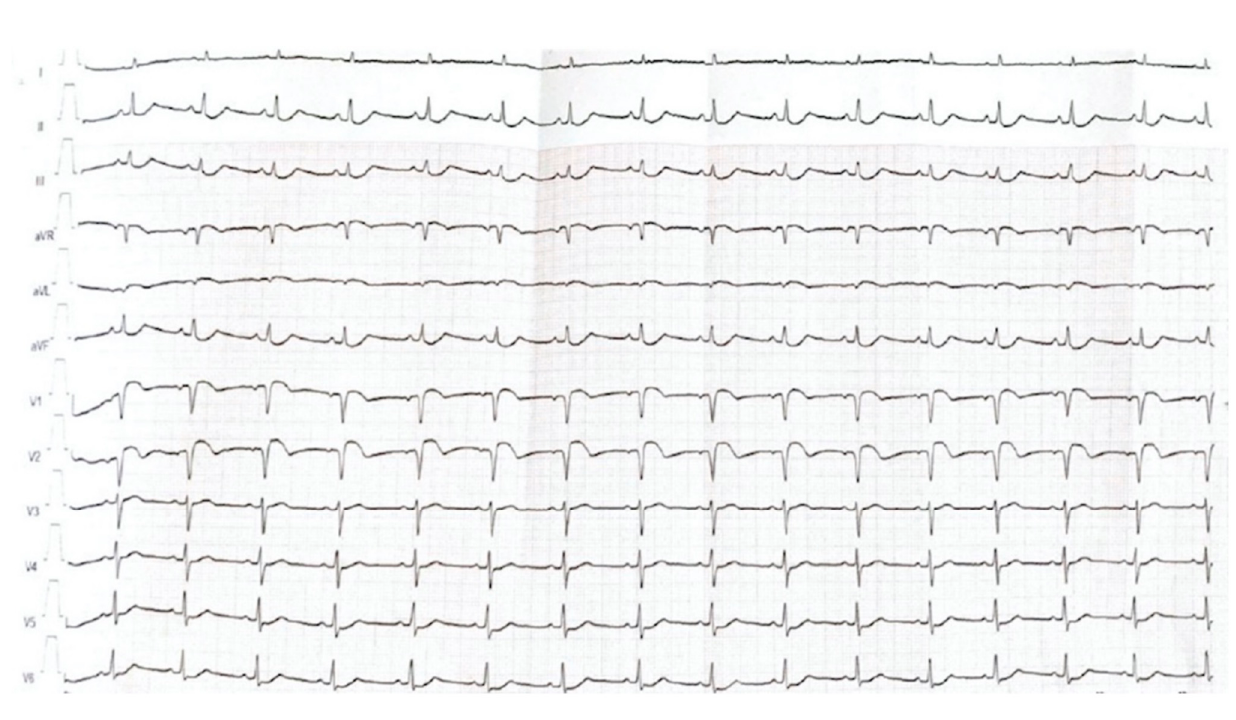
Figure 1. Electrocardiogram depicting sinus rhythm, ST segment elevation in V1 and V2 and mirror image in the inferior leads (DII, DIII and aVF).